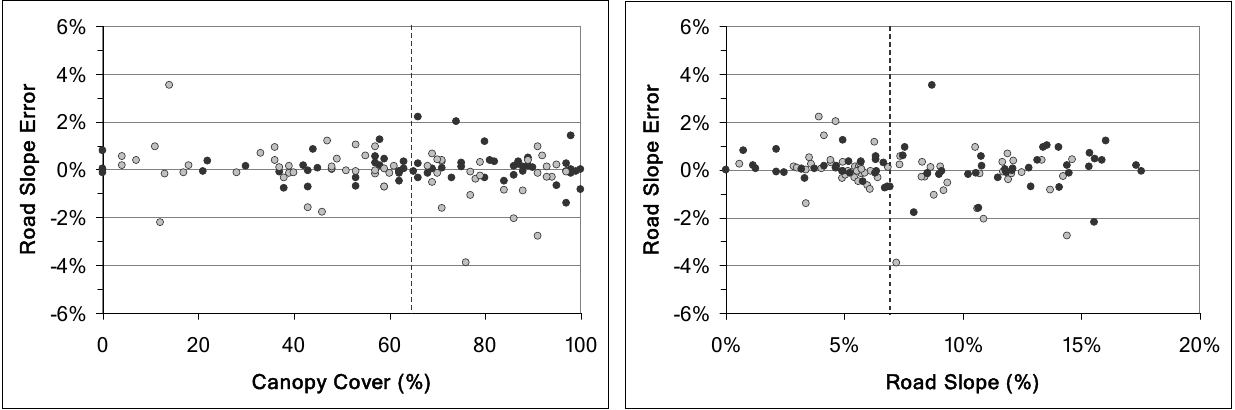
Figure 10. Left: Slope measurement error versus canopy cover. Gray points denote errors within the high road slope group. Right: Slope measurement error versus road gradient. Gray points denote errors within the high canopy cover group. Dashed vertical line denotes division between groups.